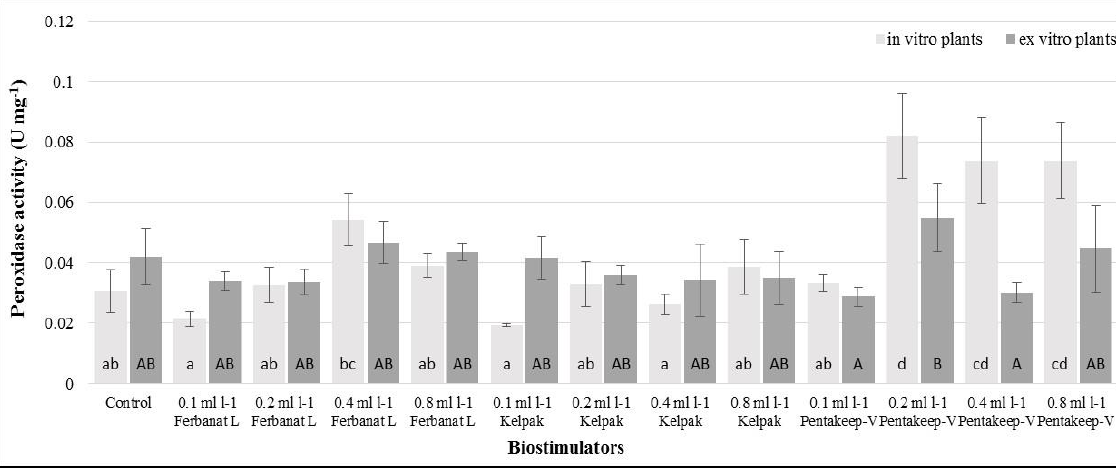
Figure 4. Peroxidase enzyme activity of in vitro and ex vitro Hosta ’Gold Drop’ plants. Values are mean ± SD. Bars with different letter are significantly different by Tukey’s and Games-Howell’s comparison test at